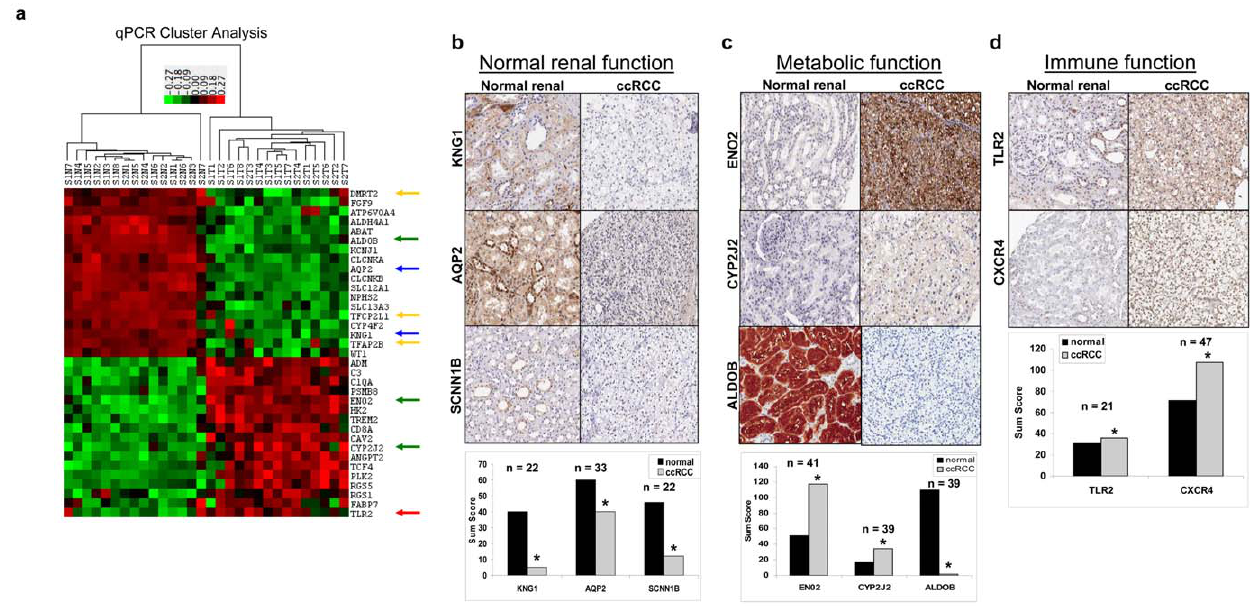
Figure 2. Validation of gene expression findings in clear cell renal cell carcinoma. a. Heatmap generated with qPCR data of DTFs and various genes related to three biological alterations. Upregulation of genes is indicated in red, downregulation is indicated in green, and similar expression is indicated in black, as generated by Cluster 3.0. b. IHC of proteins related to normal renal function (KNG1, AQP2, SCNN1B). c. Immune function (TLR2, CXCR4). d. Metabolic function (ENO2, CYP2J2,ALDOB). This pattern of expression is in accord with the microarray findings. Sum scores are shown with n as indicated. *p , 0.01 when comparing ccRCC to normal match.